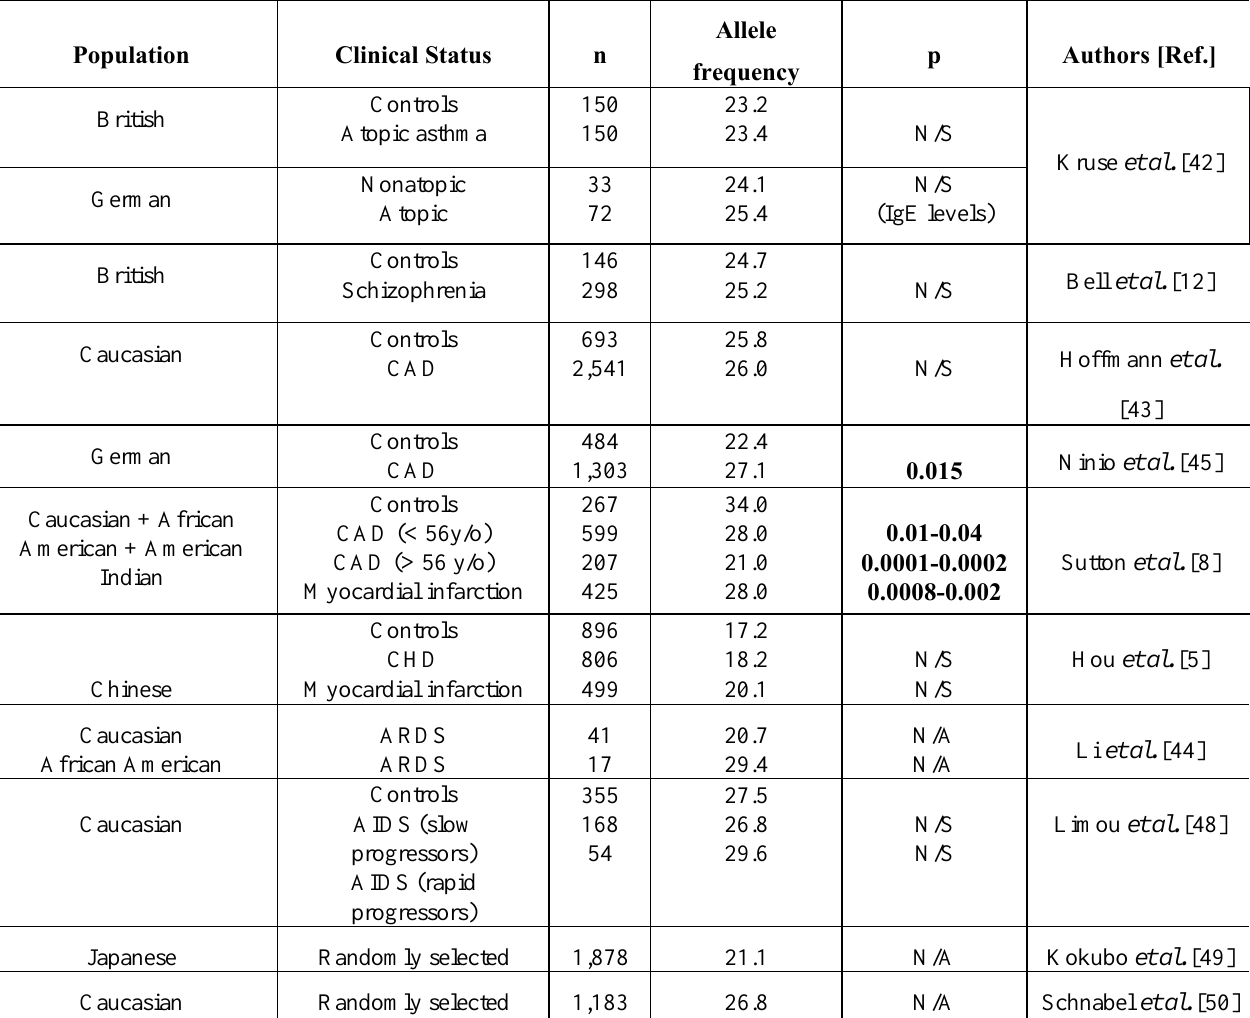
Allele p Authors [Ref.] frequency Kruse et al. [42]